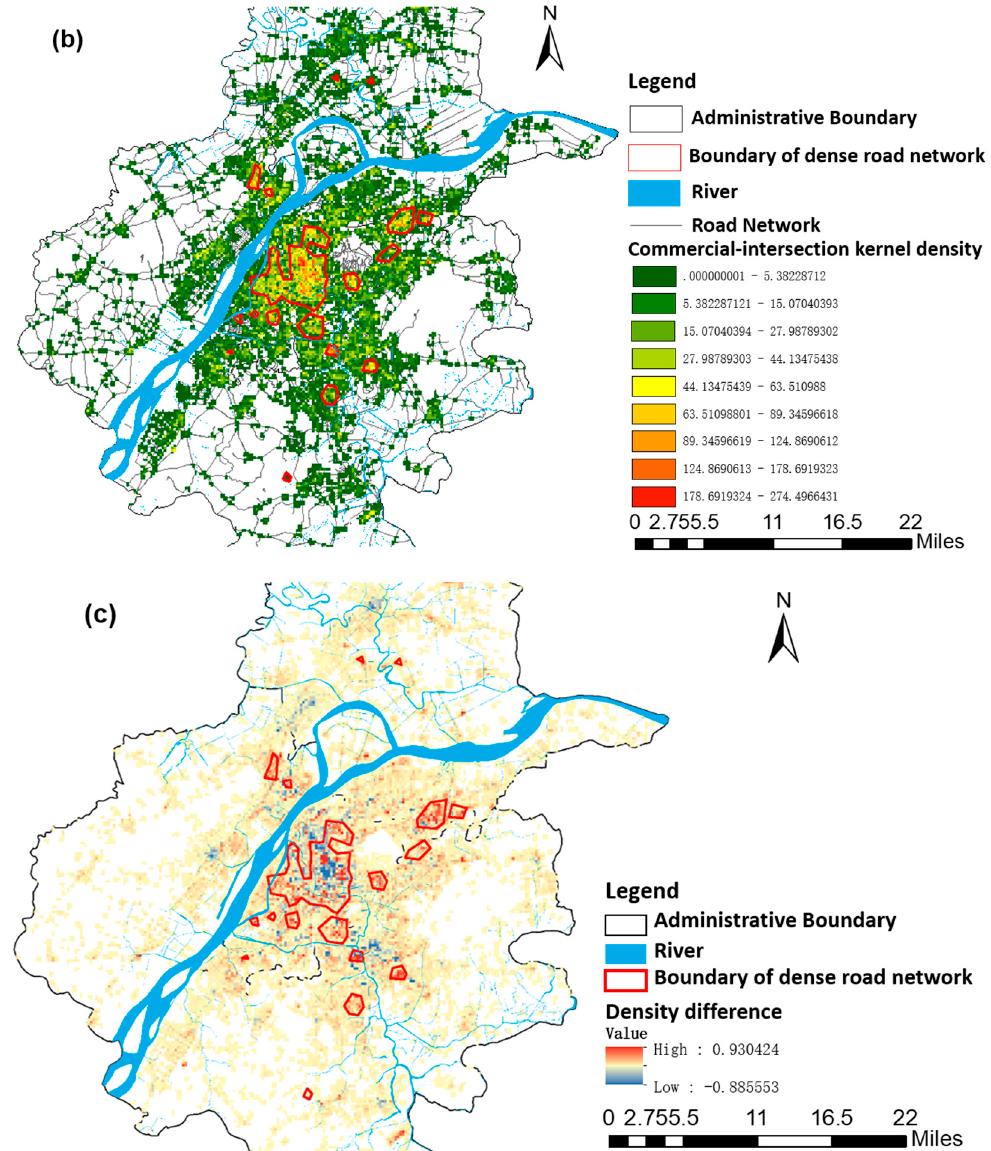
Figure 9. Commercial kernel density surface and commercial-intersection kernel density surface: ( a ) the kernel density surface of the commercial POIs at determined by planar KDE with 300-m bandwidth, ( b ) the commercial-intersection kernel density surface as determined by commercial-intersection KDE with 300-m bandwidth, and ( c ) the density difference map between the commercial kernel density surface and commercial-intersection kernel density surface.